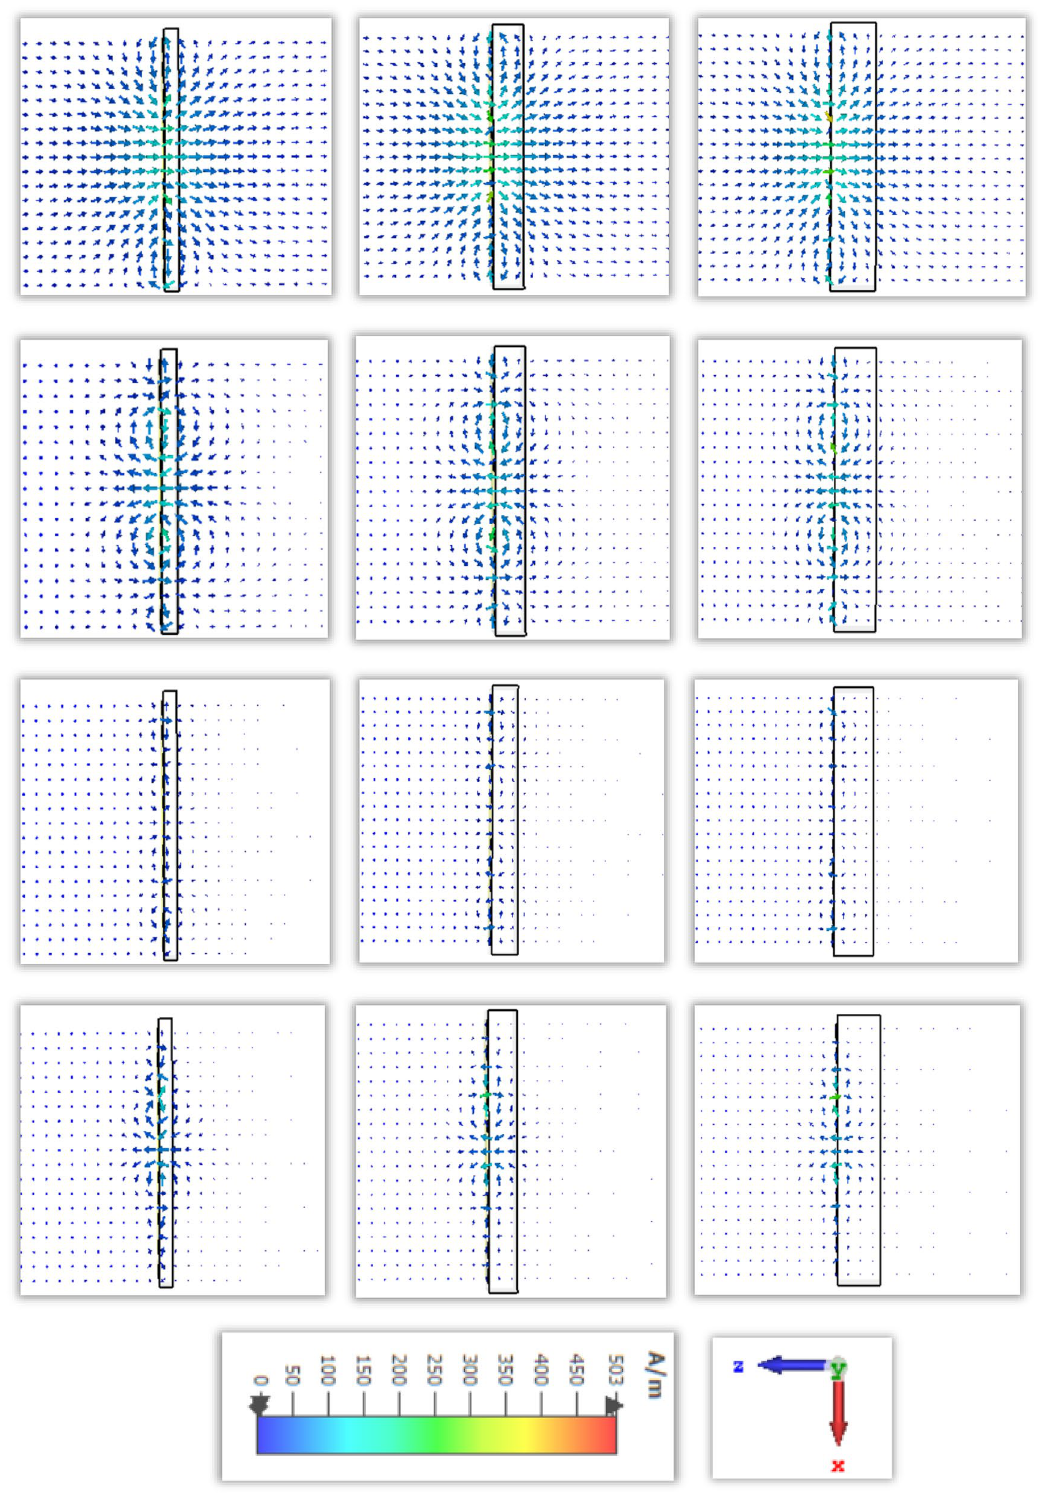
Figure 15. Magnetic field distribution for different thickness in row-wise ascending from the top order for 1.87, 2.55, 4.32, 5.46 GHz